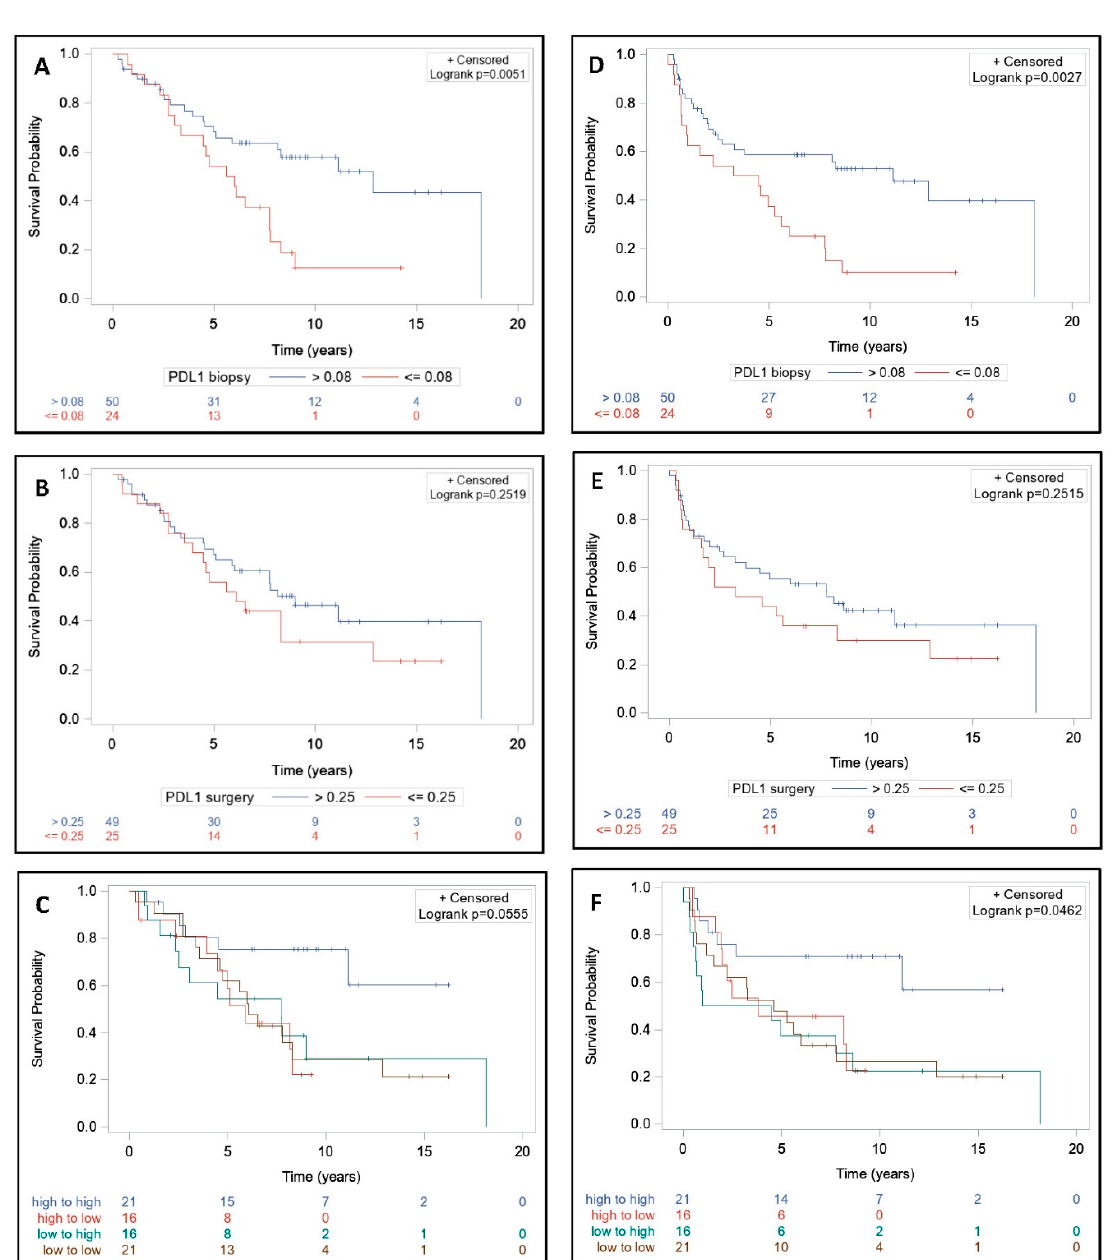
Figure 4. Impact of PD-L1 expression on overall survival (OS) and progression-free survival (PFS) before and after treatment. Patients ( n = 74) were treated with neoadjuvant short-course radiotherapy or long-course concurrent chemoradiotherapy followed by surgery. Biopsies and surgical specimens were collected and PD-L1 expression was retrospectively detected by immunohistochemistry using the monoclonal QR1 anti-PD-L1 antibody (Diagomics). The expression of PD-L1 on cell membranes and cytoplasms was automatically quantified by scripts using the software QuPath based on the percentage of stained cells (total tumor and stromal cells) in three regions per slide. The OS and PFS according to the first tercile of PD-L1 + cells rate on biopsies ( A , D ); OS and PFS according to the first tercile of PD-L1 + cells rate on surgical specimens ( B , E ); and OS and PFS according to the first tercile of PD-L1 + cells rate on PDL1 expression evolution before and after treatment ( C , F ), respectively. OS and PFS curves were estimated using the Kaplan–Meier method. The log-rank test was used to compare survival curves.